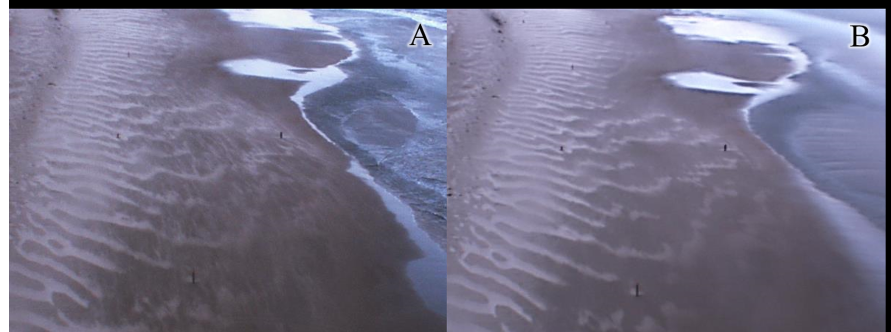
Figure 3. Example of a snapshot ( A ) and timex image ( B ). Streamers and waves are visible in the snapshot, but they are blurred out in the timex image. The images were taken on 25-09-2012 around 6.00 h (GMT). The hourly mean wind velocity U was 8 m/s and the wind direction θ was 97 ◦ . θ = 0 ◦ is cross-shore from the west, θ = − 90 ◦ is the alongshore wind coming from the north, and θ = 90 ◦ is alongshore from the